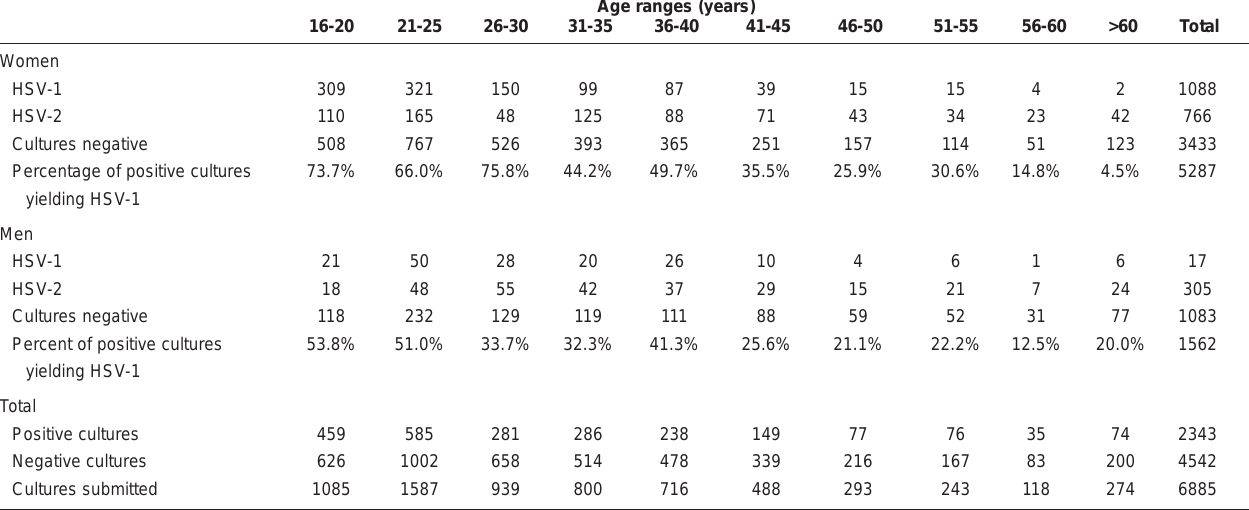
TABLE 1 Summary of the results of genital source herpes simplex virus (HSV) cultures submitted to the Queen Elizabeth II Health Sciences Centre between April 1998 and December